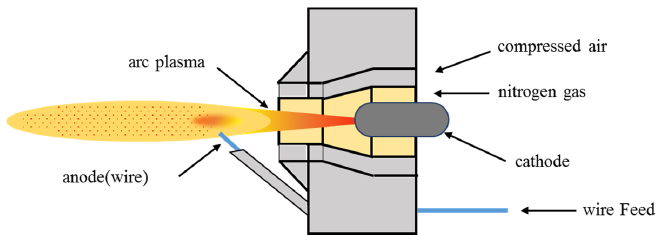
Figure 1. A cross ‐ section of the “plazwire” system. Figure 1. A cross-section of the “plazwire” system.